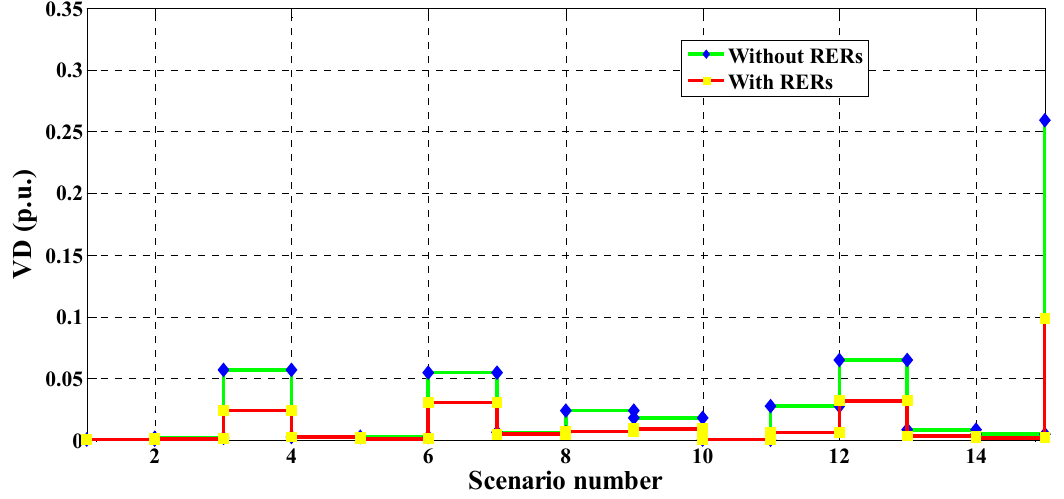
Figure 21. The 15-bus system emissions.